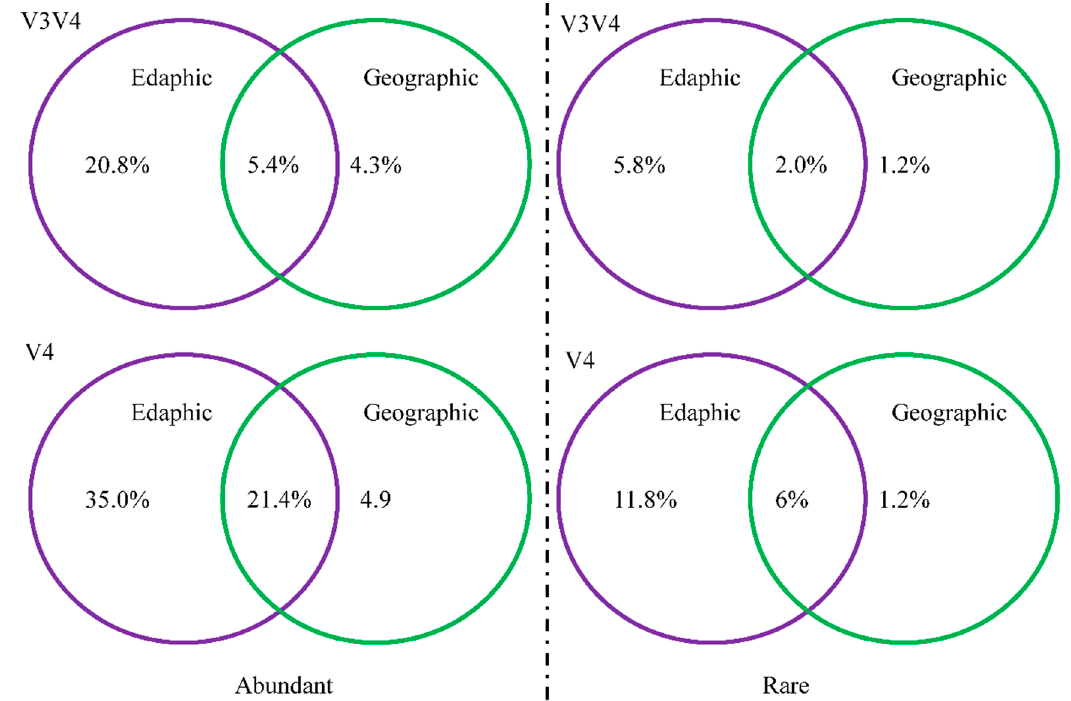
Figure 5. The variation in the community structure of abundant and rare soil bacteria explained by edaphic and geographic factors. Primer pair 520f/802r targeted the V4 region of the 16S rRNA gene; primer pair 338f/806r targeted the V3 – V4 region of the 16S rRNA gene.